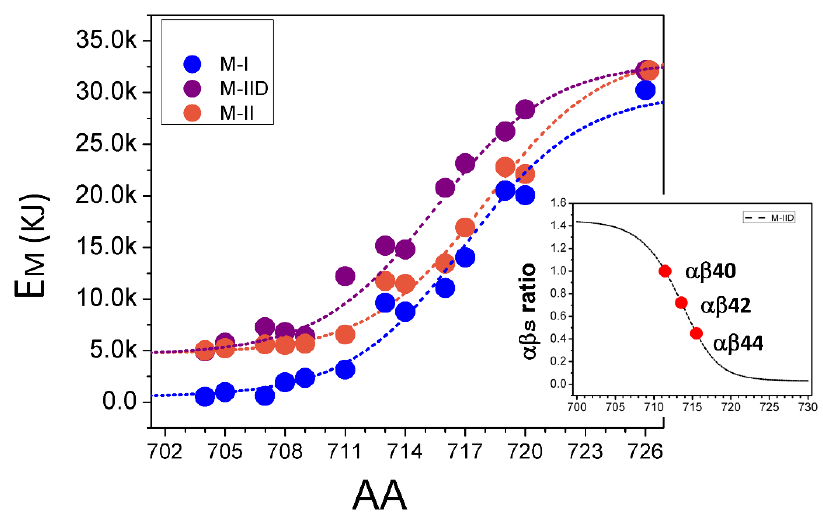
Figure 2. The membrane-association energy of A β peptides. A membrane-association energy ( E M ) of A β peptide is plotted as a function of Aβ length resulting from γ -secretase proteolysis between positions 704 and 725. E M is calculated for M-I (blue circles) and M-II (orange circles) conformations and for M-IID conformation that corresponds to M-II conformation with Asp residue added at carboxy-terminal end of Aβ peptide (purple circles). The results were fitted (smooth lines) using Equations (1) and (2). The insert shows predicted ratio of soluble and membrane associated Aβ peptides ( αβs ratio) as a function of peptide size based on Equation (4). Red dots are the αβs values calculated for A β 40, A β 42 and A β 44 as indicated.